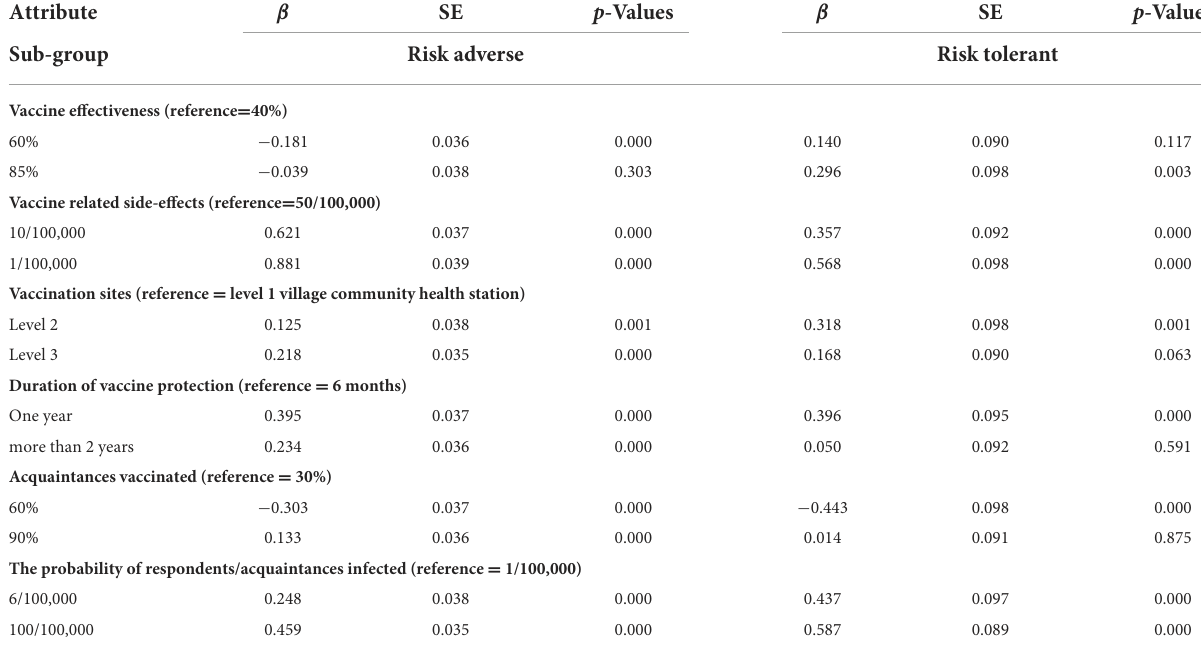
TABLE 7 Sub-group analysis for student risk